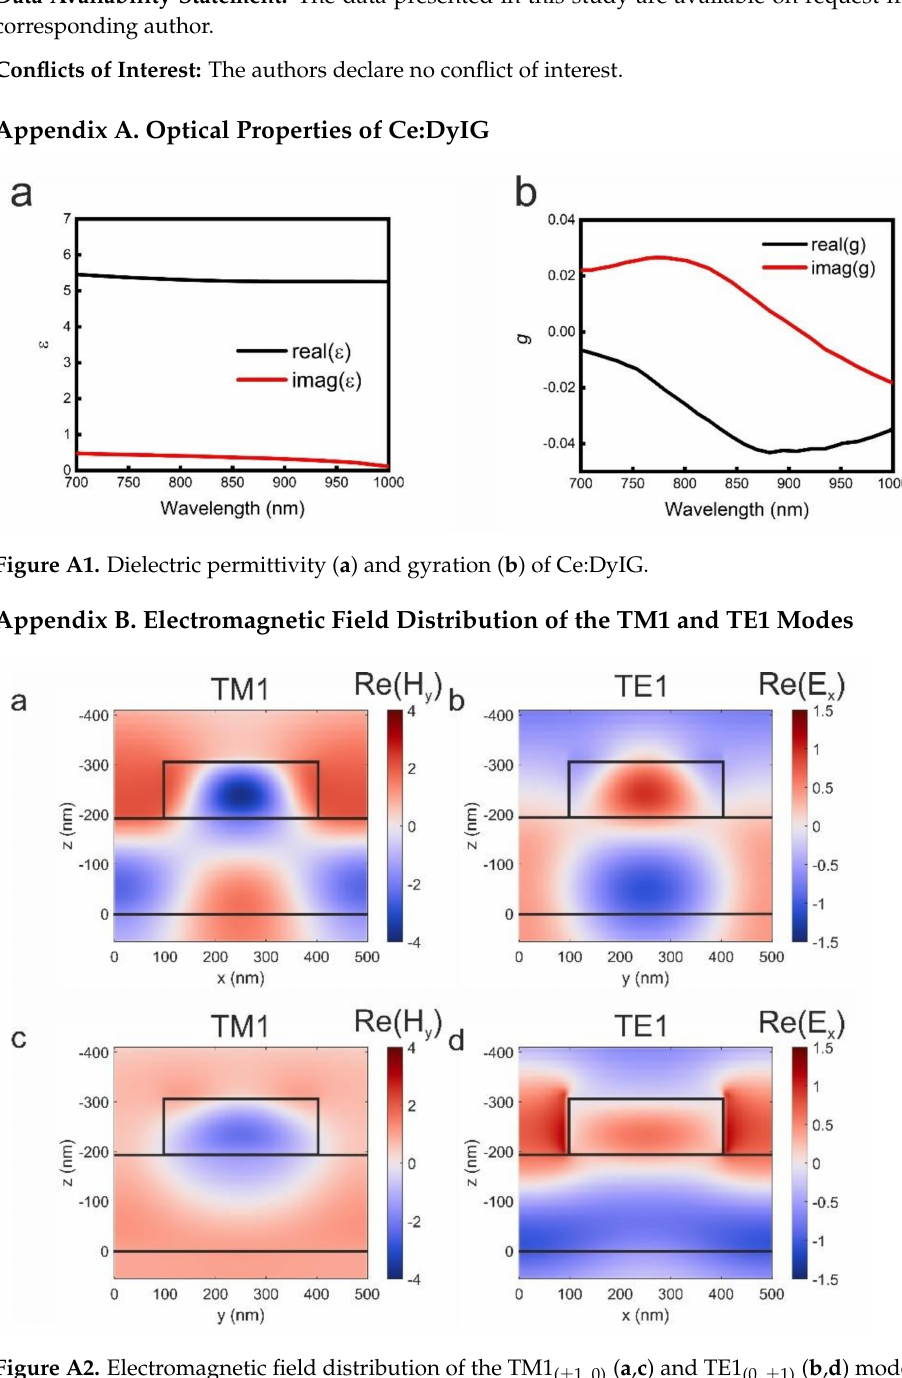
Figure A2. Electromagnetic field distribution of the TM1 ( ± 1, 0) ( a , c ) and TE1 (0, ± 1) ( b , d )